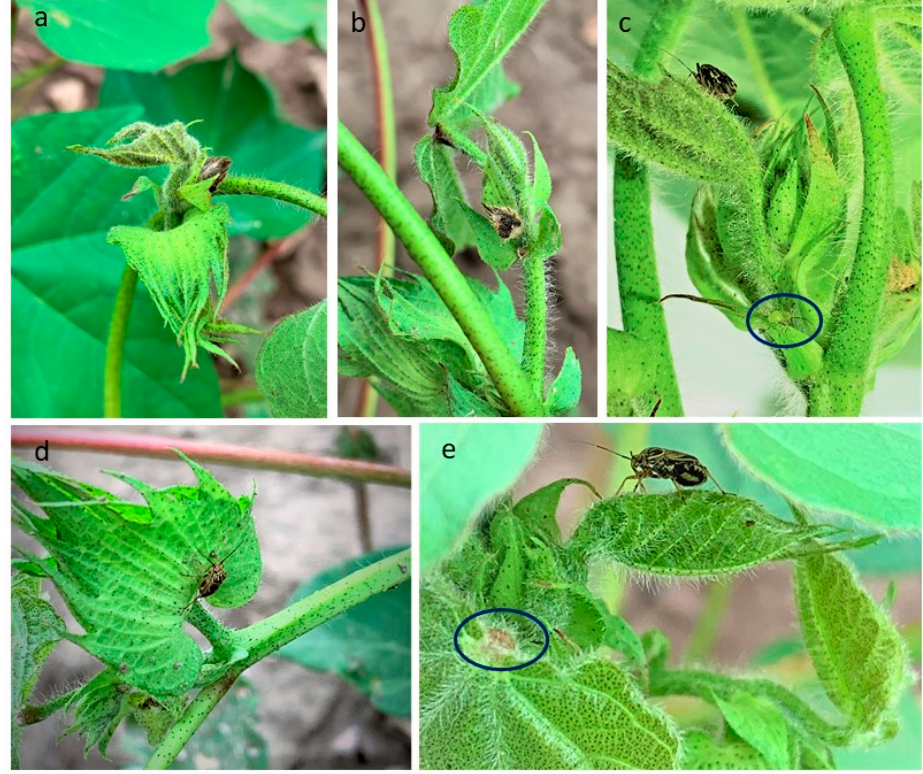
Figure 2. Lygus lineolaris feeding and the damage on cotton squares. ( a , b ) Aborted black cotton squares from L. lineolaris feeding; ( c ) L. lineolaris adult and early instar nymph (blue oval) on a cotton square; ( d ) L. lineolaris adult feeding on a cotton square; ( e ) L. lineolaris adult on a late-stage cotton square, and the feeding damage on an early-stage cotton square called “blasted square” (blue oval).